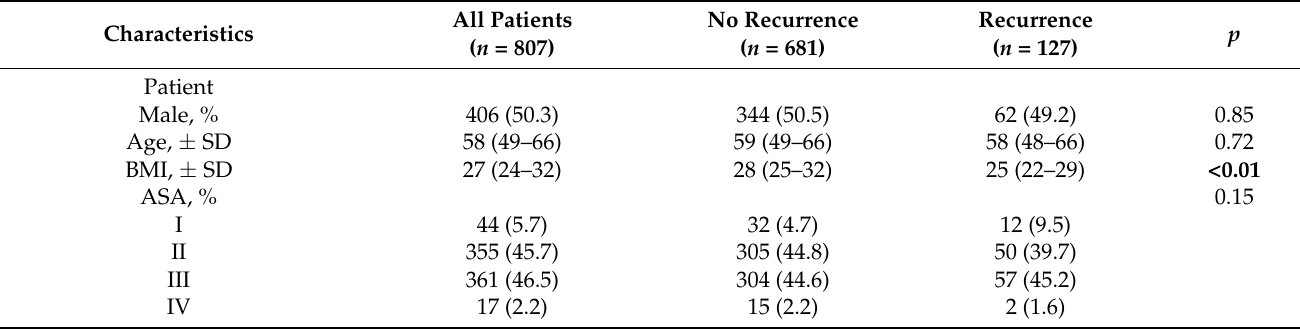
Table 1. Patient and tumor